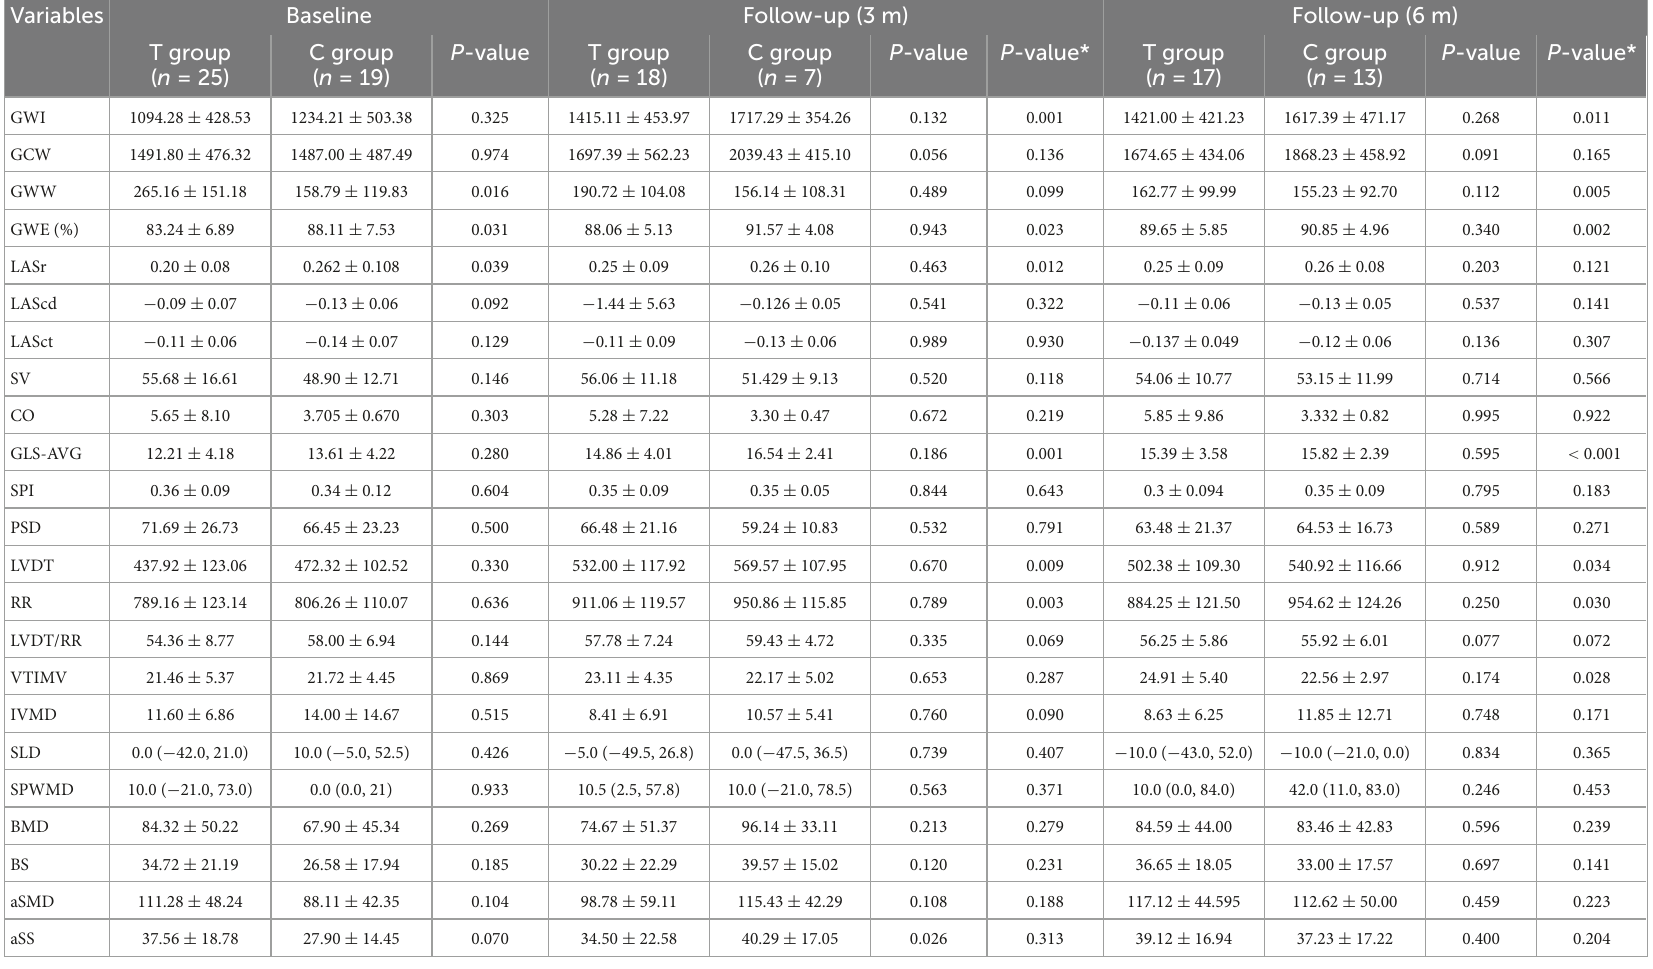
TABLE 3 Tissue synchronization imaging changes between the two groups from the baseline to